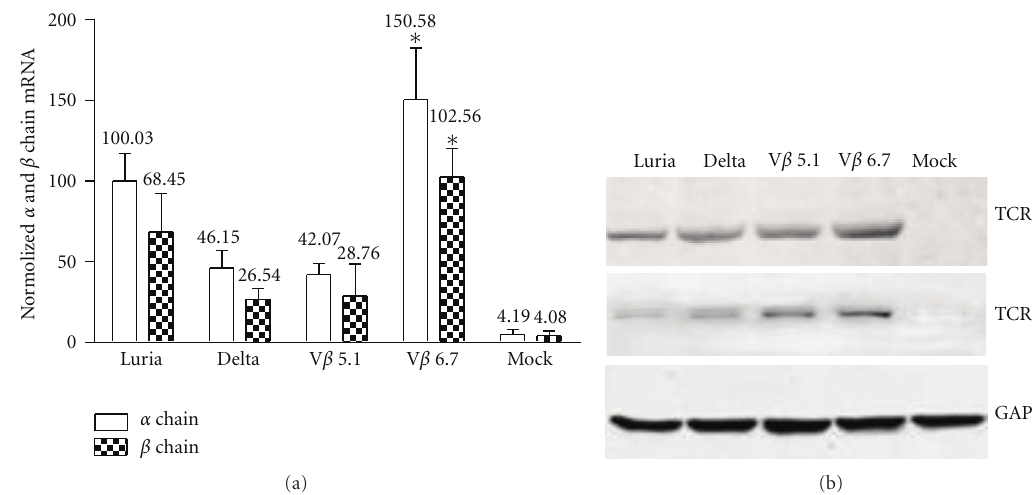
Figure 2: Comparison of lentiviral vector constructions driven by di ff erent T-cell-specific promoters. (a) Comparison of mRNA level of TCR PL5.05 α and β chain under di ff erent T-cell-specific promoters by using quantitative RT-PCR. The number on each column corresponds to the mean number of mRNA normalized by GADPH mRNA, and the vertical bar represents the SD. (b) Conventional western blot assays from HSB2 cells which are infected with lentivirus containing TCR α and β chains driven by V β 6.7, Delta, V β 5.1, and Luria promoters. Either Flag or Myc fusion proteins were transferred to membranes and incubated with the indicated antibody. Approximately, fifty micrograms of each protein per lane were applied for electrophoresis. Equal protein loading was controlled by staining of GAPDH (lower panel). Statistical analysis was determined using the Student t -test with ∗ P < 0 . 05, compared to other